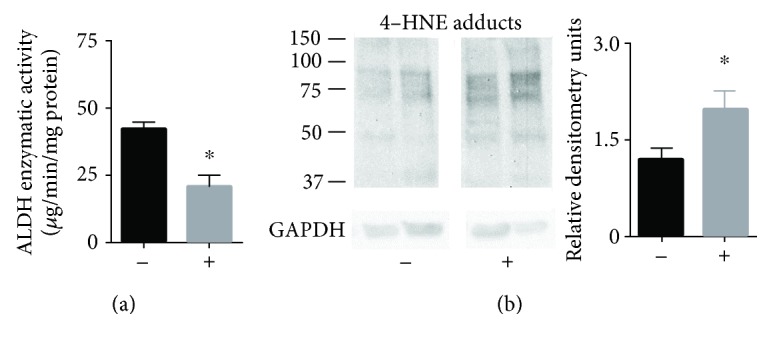
ALDH enzyme activity and 4-HNE protein-induced adduct formation taken from biopsies of kidneys 45 minutes after reperfusion. (a) ALDH enzymatic activity when challenged with acetaldehyde. n = 8/group, ∗
P < 0.005; (b) 4-hydroxynonenal-induced protein adducts. Representative western blot in addition to quantification by densitometry. Western blots were normalized to GAPDH. (-) = donor kidneys without delayed graft function; (+) = donor kidneys with delayed graft function, n = 10/group, ∗
P < 0.05.